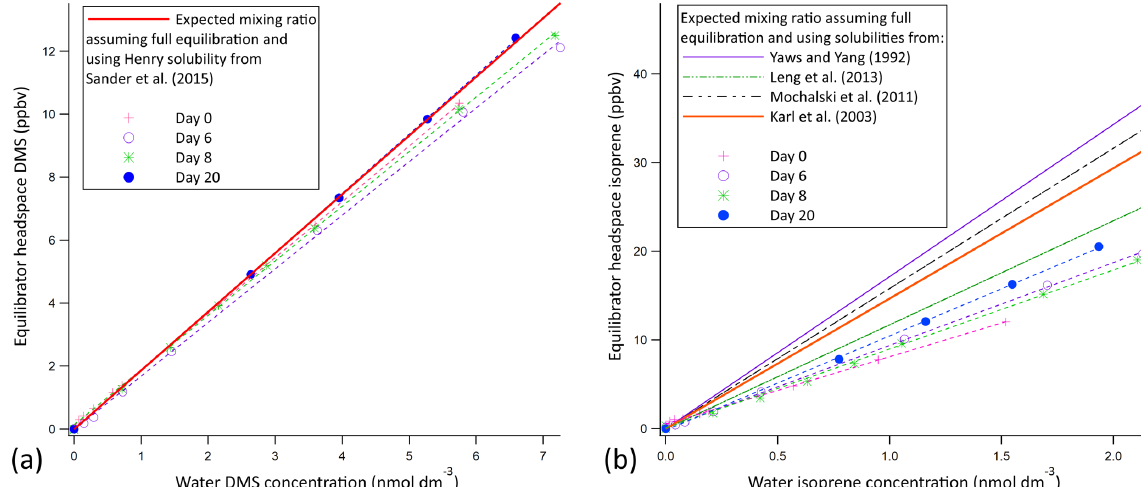
Figure 2. Evasion calibration curves for DMS (a) and isoprene (b) . The average slope of the experimental calibration curve was found to be 1.77ppbvnmol 1dm 3 ± 4% and 9.12ppbvnmol 1dm 3 ± 14% for DMS and isoprene, respectively; errors represent the standard deviation over a 3-week period. The full equilibration slope was computed to be 1.87ppbv (nmol dm − 3 ) − 1 and 14.69ppbv (nmol 1dm − 3 ) − 1 for DMS and isoprene, respectively (using Burkholder et al., 2015, for DMS solubility and Karl et al., 2003, solubility with Leng et al., 2013, temperature dependence). This suggests approximately 100% and 62% equilibration efficiency for DMS and isoprene, respectively. Error bars are too small to display, but the noise associated with the measurement was found to be 0.0069 and 0.00058ppbv for DMS and isoprene, respectively. This was calculated as the SD of 10 consecutive water blank